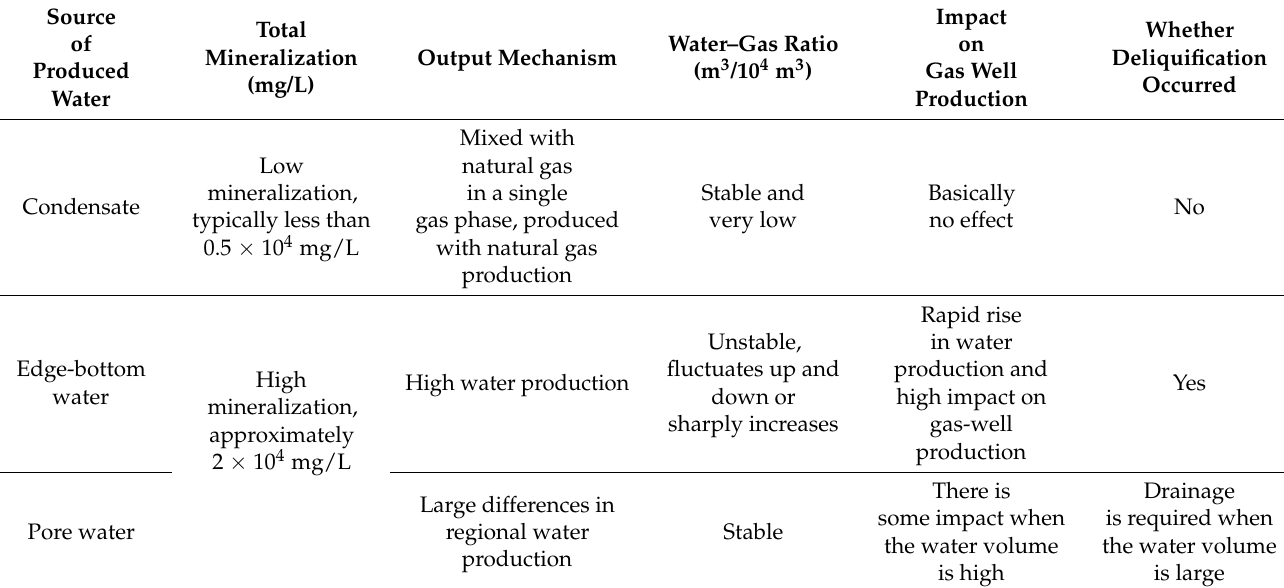
Table 5. Classification of water production types of gas reservoirs in the Changbei gas field.